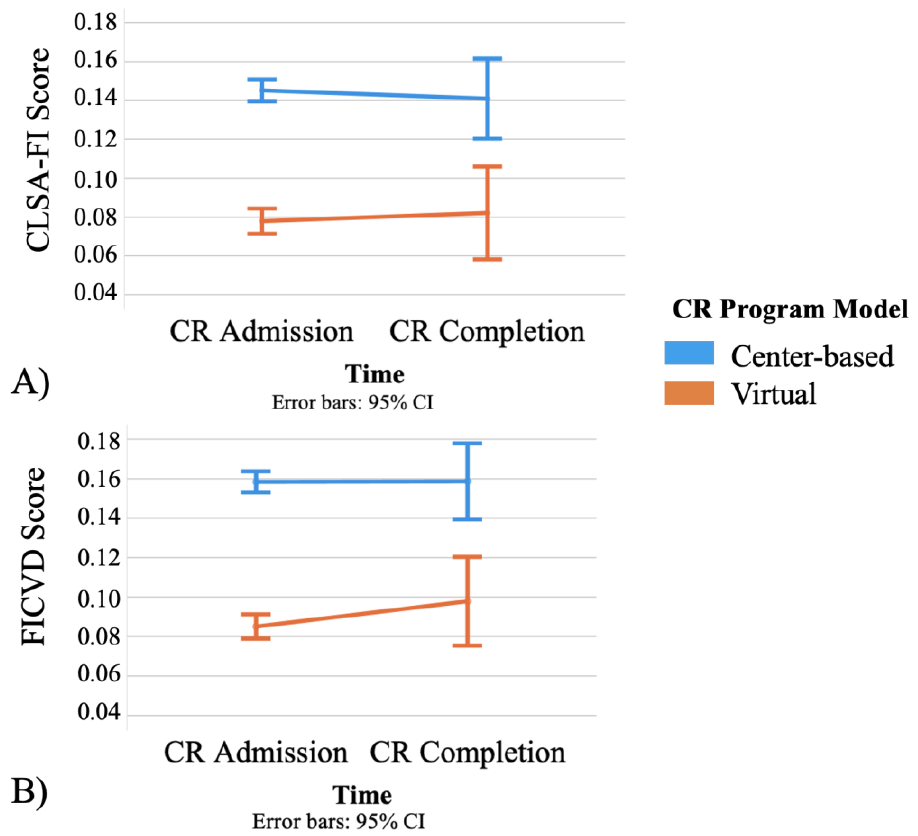
Figure 2. (A) Estimated marginal means of CSLA-FI frailty scores at admission and follow-up; (B) Estimated marginal means of FICVD frailty scores at admission and follow-up.